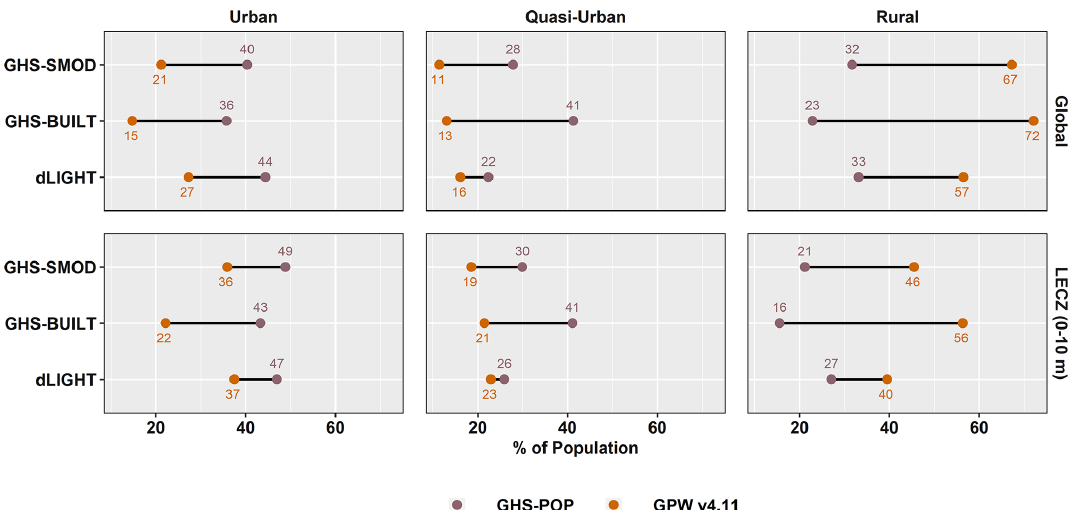
Figure B12. Percent of total population, by urban–rural classes, using different urban-proxy and population data sources, globally and in the ≤ 10m LECZ (using MERIT DEM),